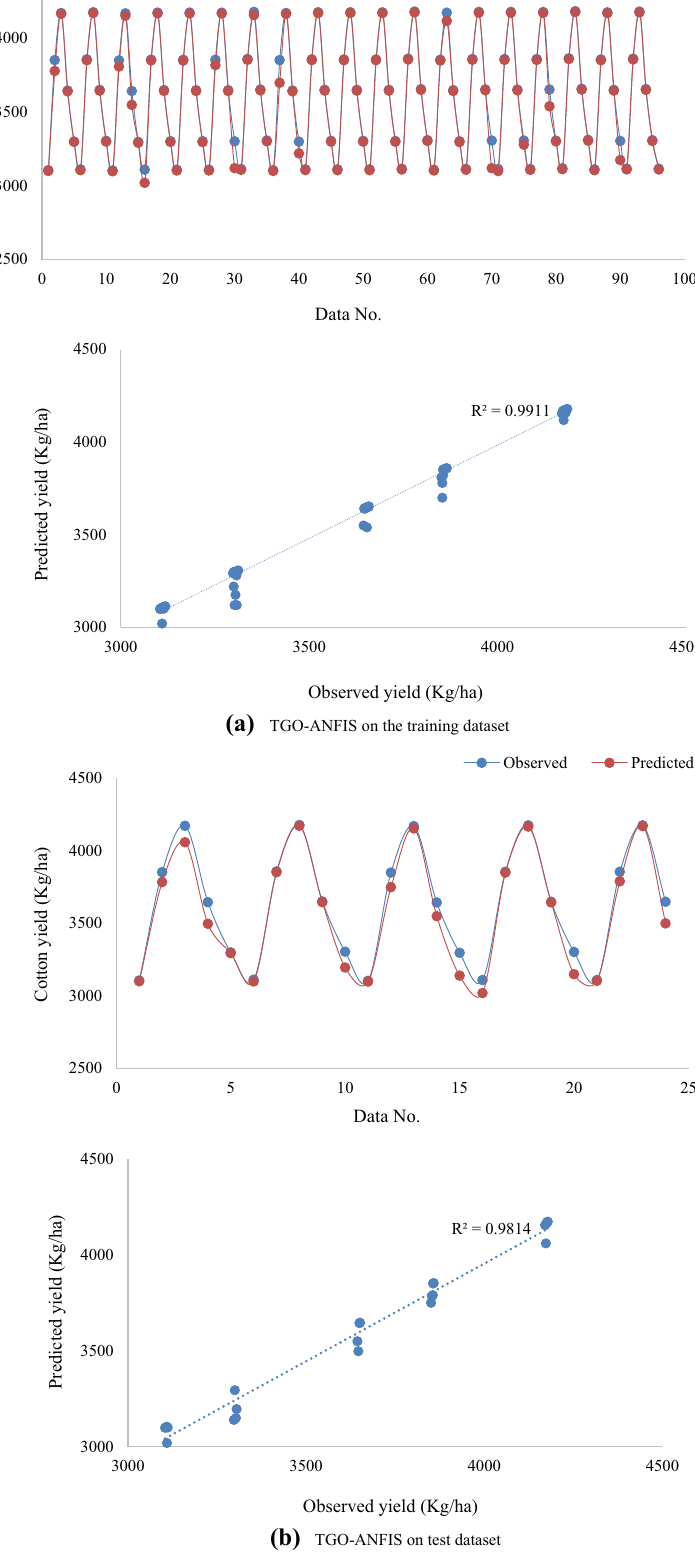
Fig. 11 a , b Predicted cotton yield using the TGO-ANFIS hybrid model in the training and test stages (Model E1